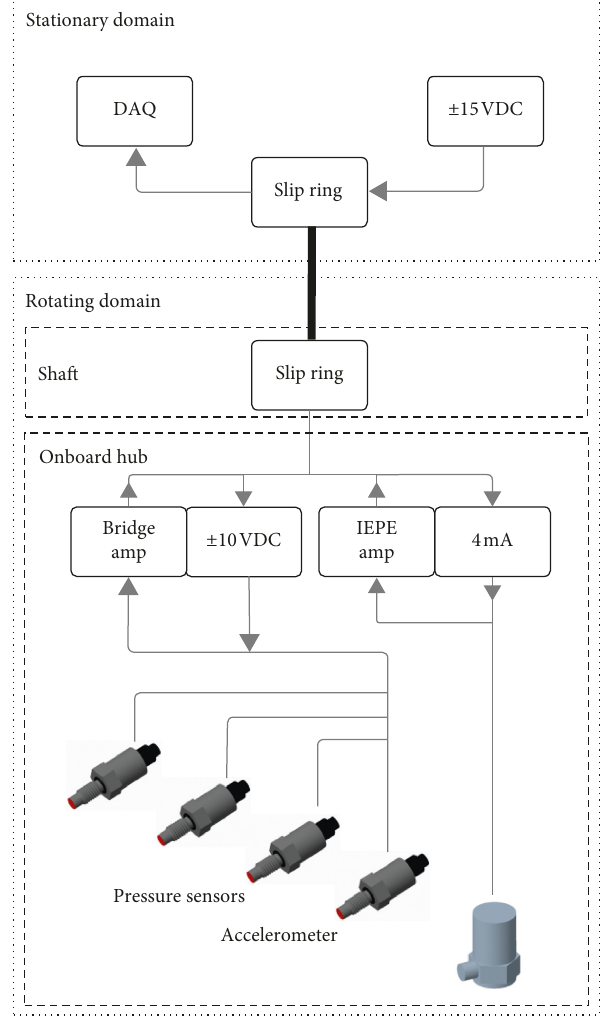
Figure 7: Overview of the measurement chain.